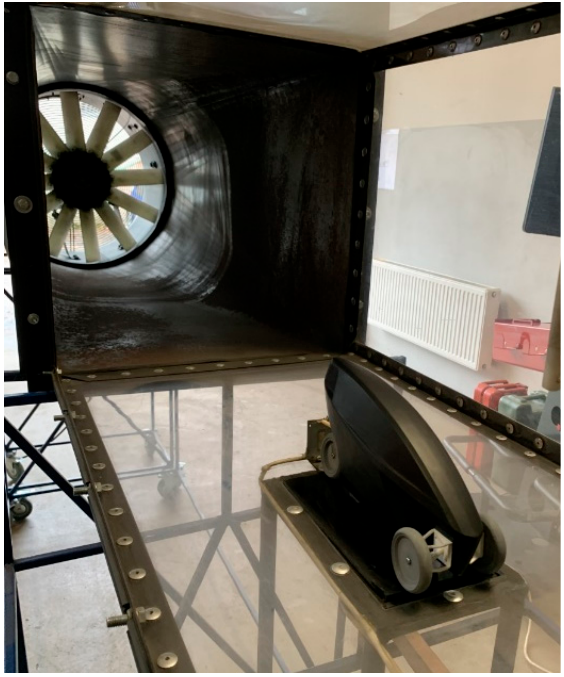
Figure 4. Three-wheeled tilting vehicle model in a wind tunnel. Table 2. Air resistance measurements results.